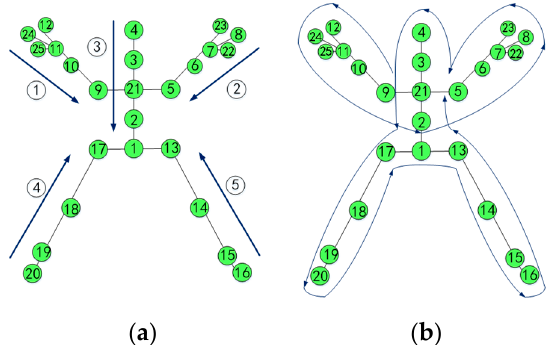
Figure 2. Different orders for skeleton arrangement. ( a ) part-based order ( b ) traversal-based order.